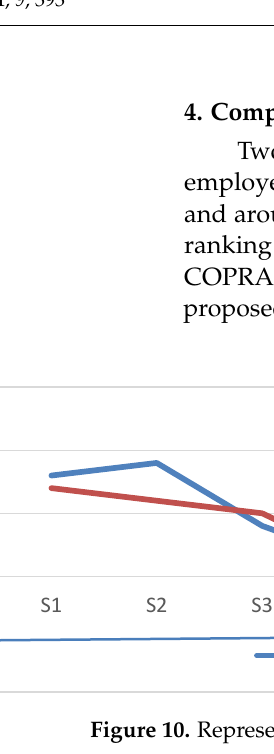
Figure 12. Sensitivity analysis ranking obtained under fuzzy AHP-COPRAS.